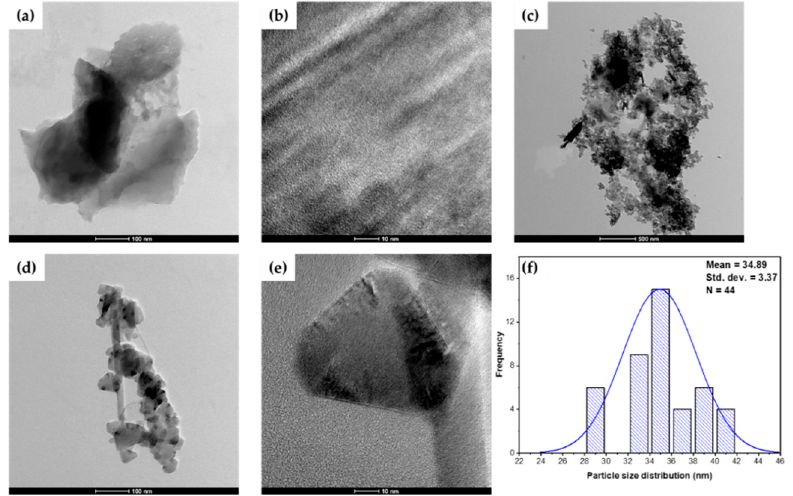
Figure 6. TEM images of the SCBC at two scales ( a ) 100 nm, ( b ) 10 nm, TiO 2 @SCBC at ( c ) 500 nm, ( d ) 100 nm and ( e ) 10 nm, and ( f ) PSD for the TiO 2 @SCBC.